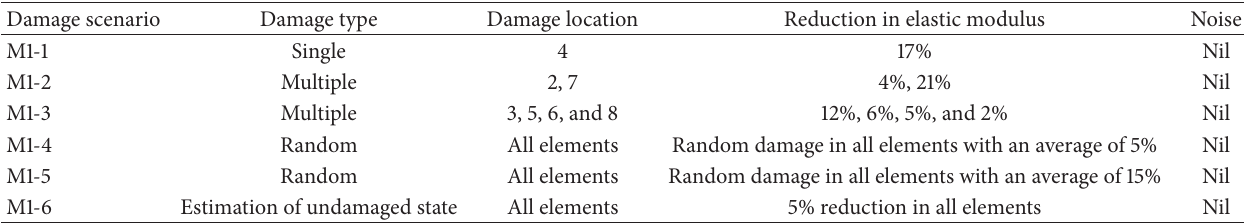
Table 2: Damage scenarios for single-span bridge.